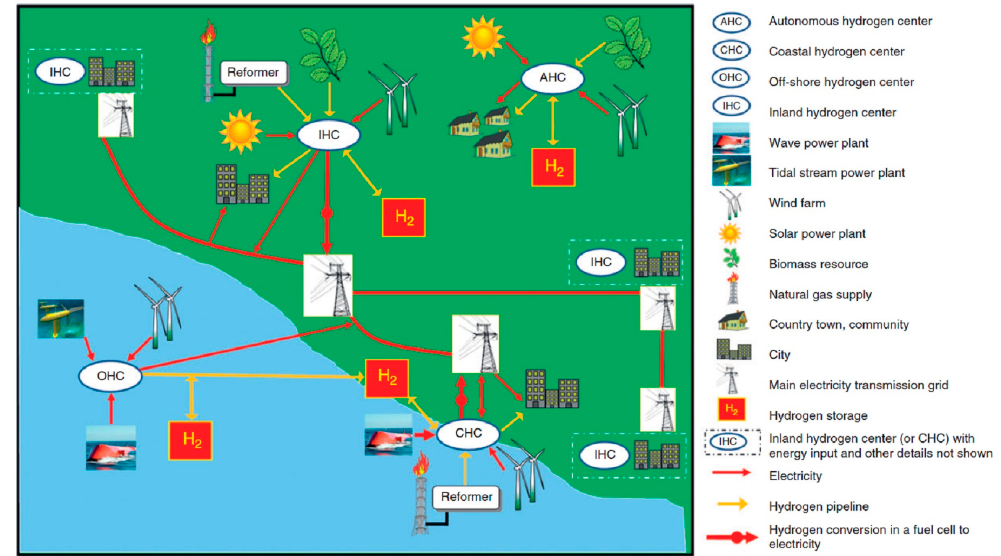
Figure 10. A schematic illustration of the sustainable hydrogen hierarchy proposed by Andrews and Shabani [16].